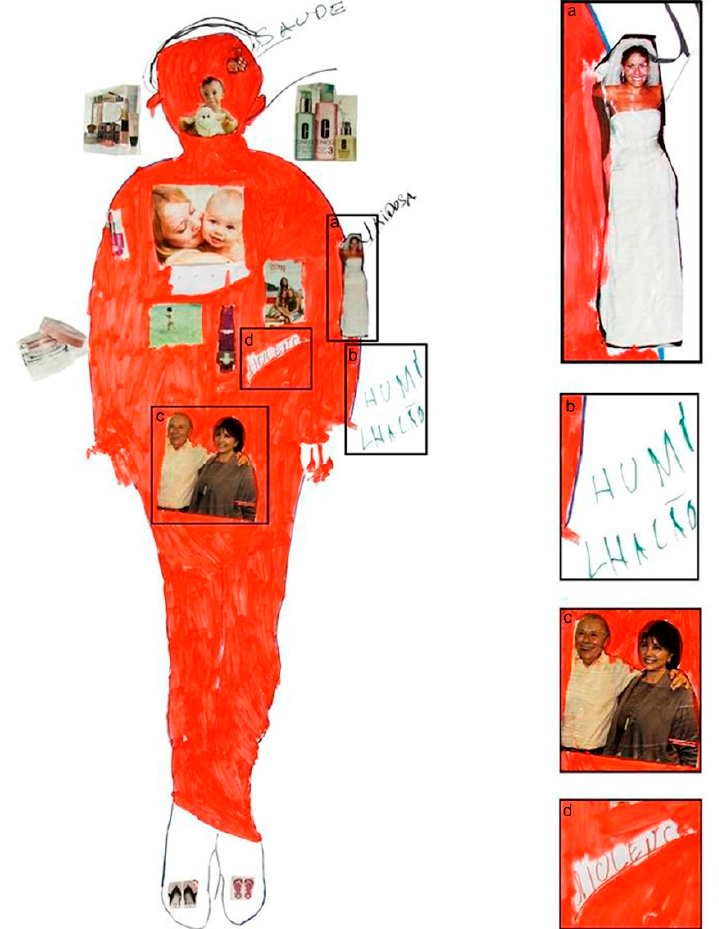
Figure 1. Body map of the participant ID 8. According to this participant, the bride represents her wedding as the most important event of her adult life ( a ). The body was colored red, which she said represented the violence she suffered and was also represented by the word “humiliation” ( b ). Her parents were highlighted as supporters ( c ), and the word “violence” was highlighted inside her body ( d ). Note: Participant used pictures from Brazilian magazines such as “Claudia” and “Veja” to illustrate her body map.